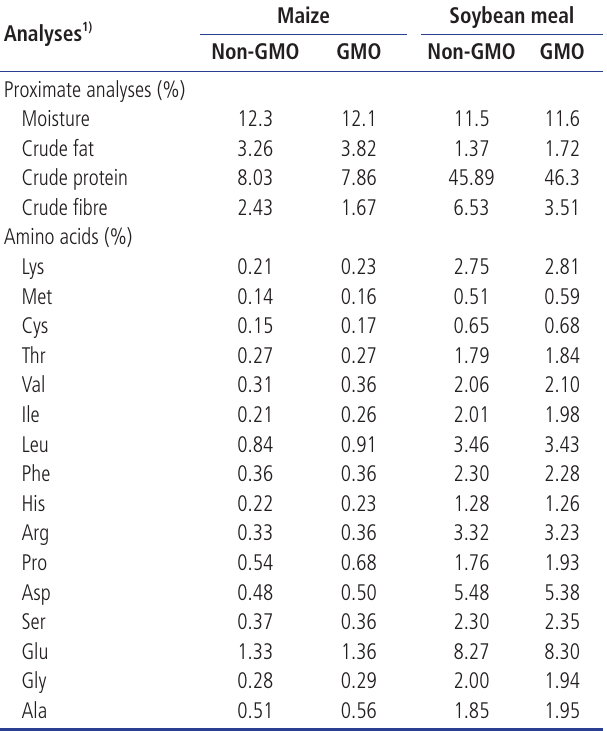
Table 3. Compositions of corn and soybean meal sample Analyses 1)